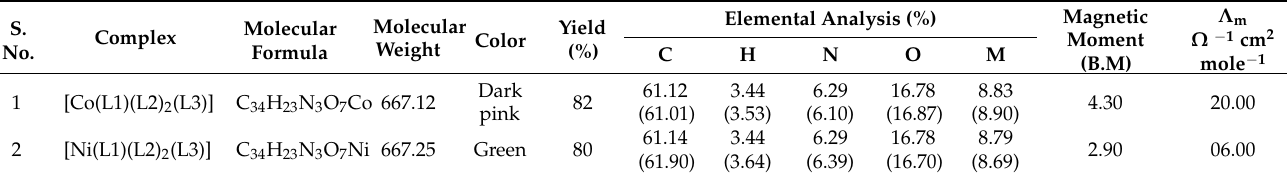
Table 1. Physical and analytical data for the mixed ligand complexes.